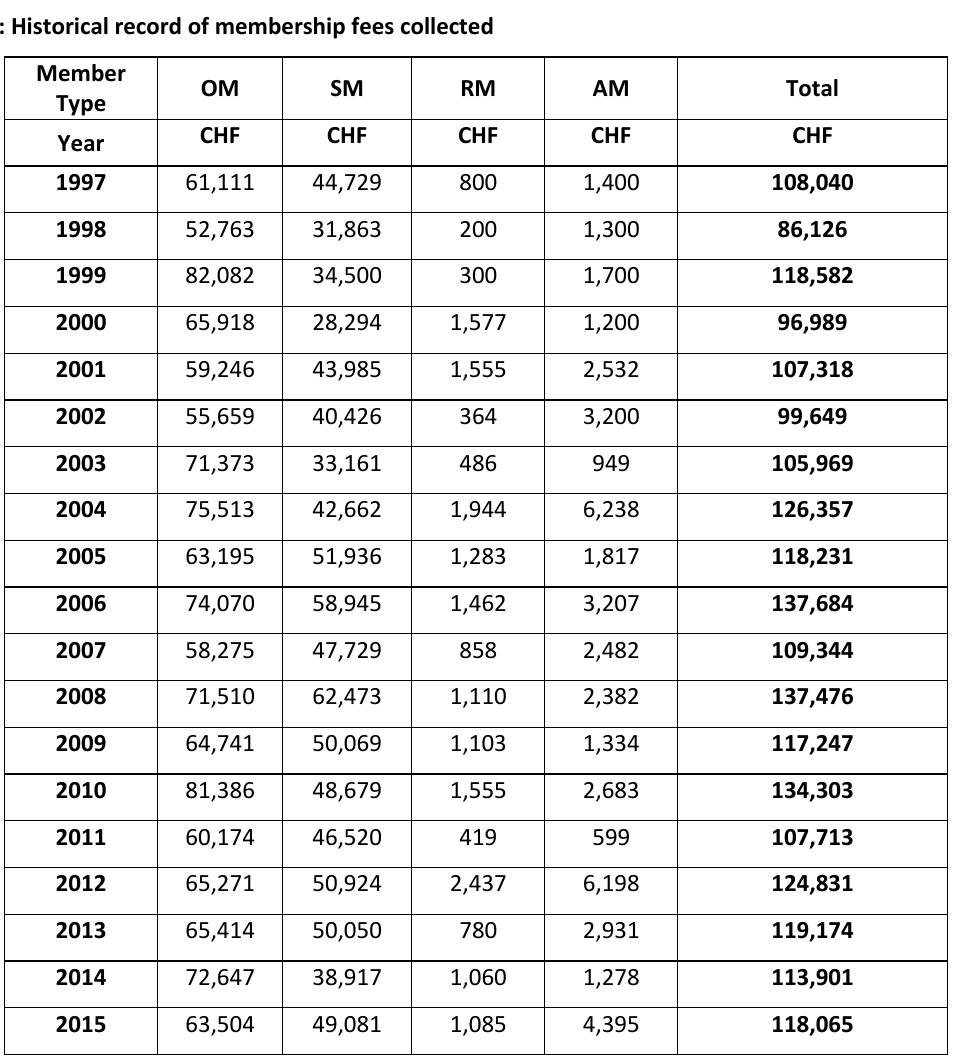
Table 5: Historical record of membership fees collected per